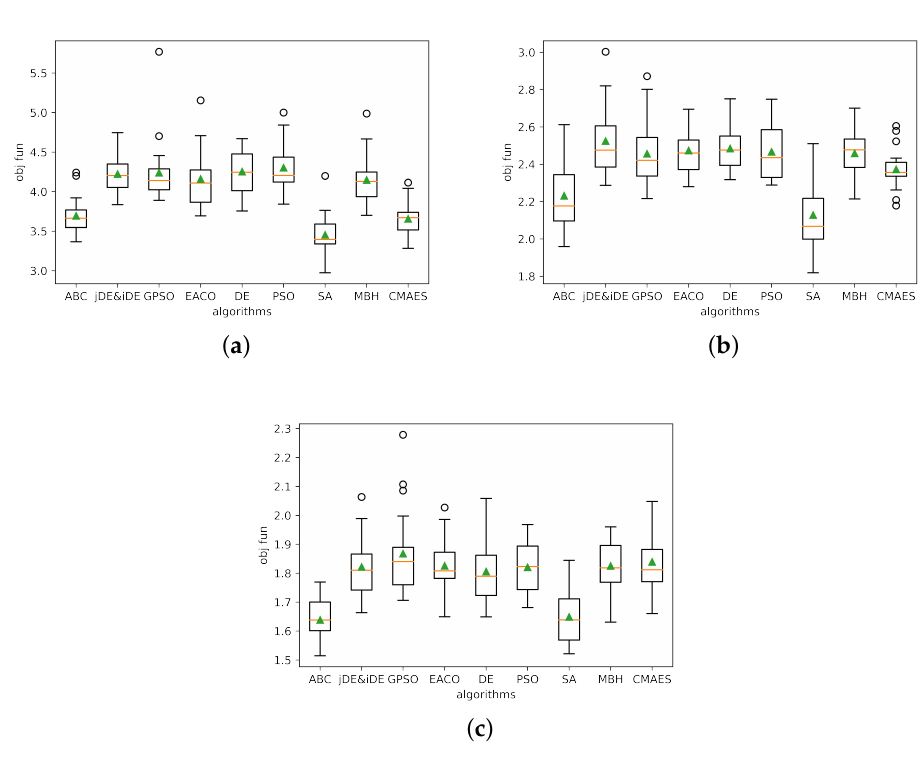
Figure 5. Distribution of best fitness over 20 trials. ( a ) N = 4; ( b ) N = 9; ( c ) N =